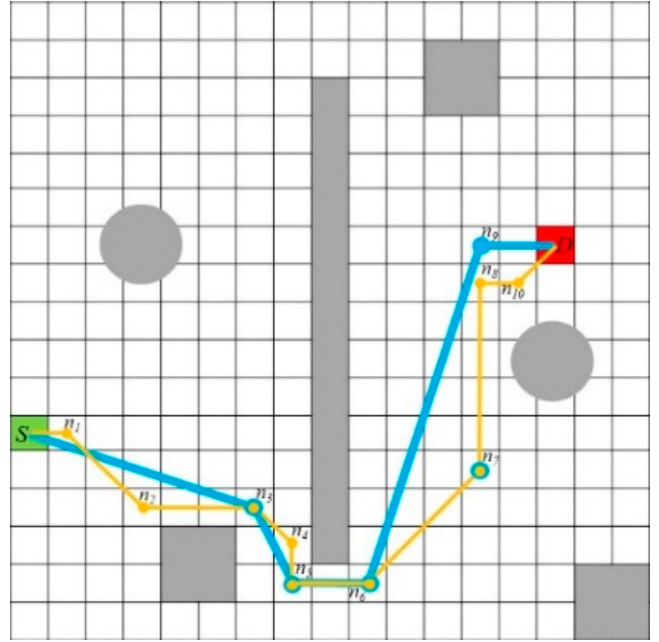
Figure 7. The obstacle avoidance path result of the 8-search-neighborhood A* algorithm is shown in yellow, L 8 = 22.899. In blue, the obstacle avoidance path result of the 48-search-neighborhood A* algorithm, L 48 = 22.047.